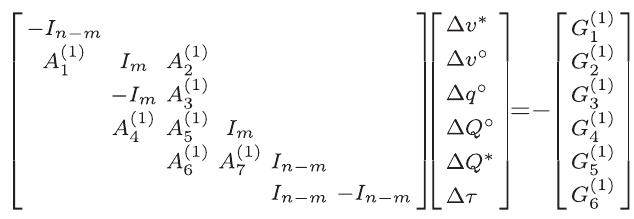
Figure 7. Diagonalized Jacobian matrix.